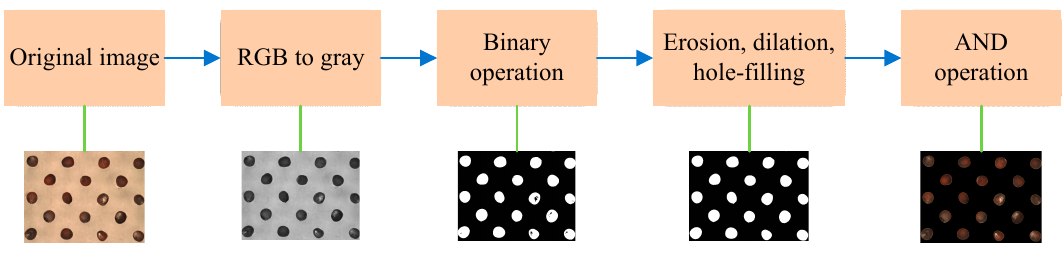
Figure 3. Image preprocessing.